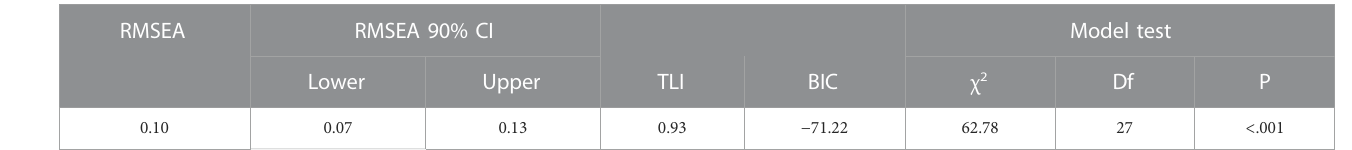
TABLE 6 Model fi t measures (N =